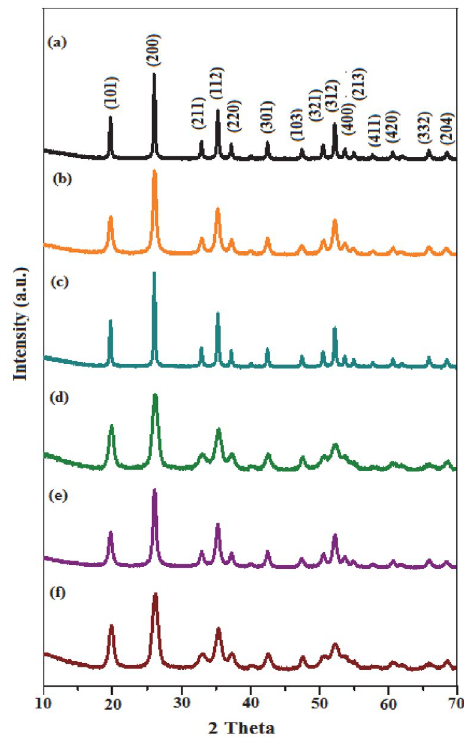
Figure 2. PXRD patterns of (a) undoped YbPO 4 (b) YbPO 4 :Tb 3+ (SC) (c) YbPO 4 :Tb 3+ (HT) (d) YbPO 4 :Tb 3+ (ST) (e) YbPO 4 :Tb 3+ (Sac) (f) YbPO 4 :Tb 3+ (CP)